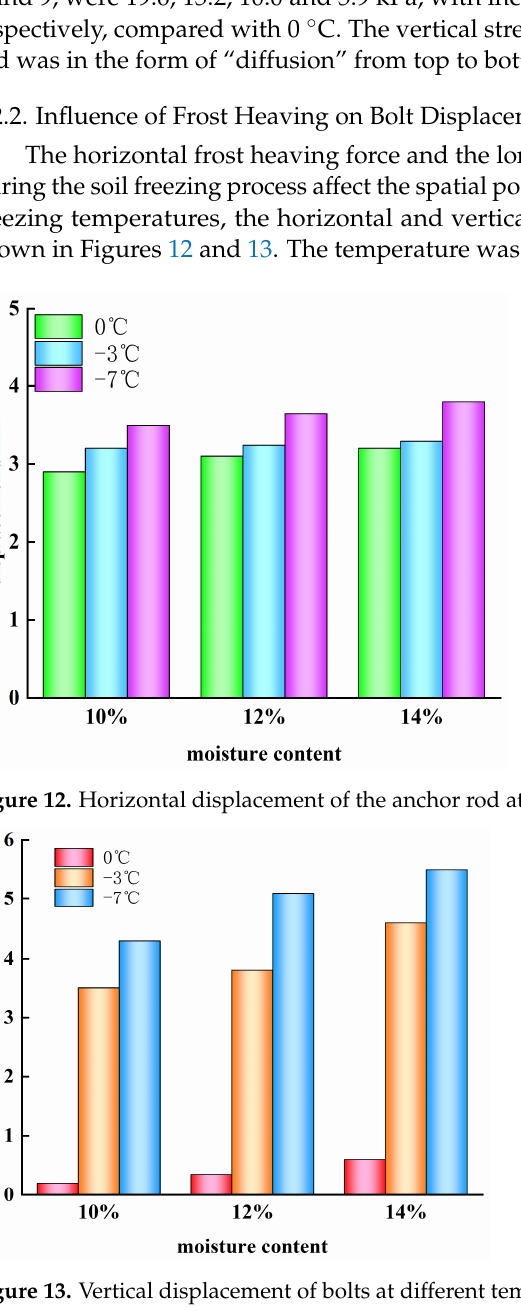
Figure 13. Vertical displacement of bolts at different temperatures.